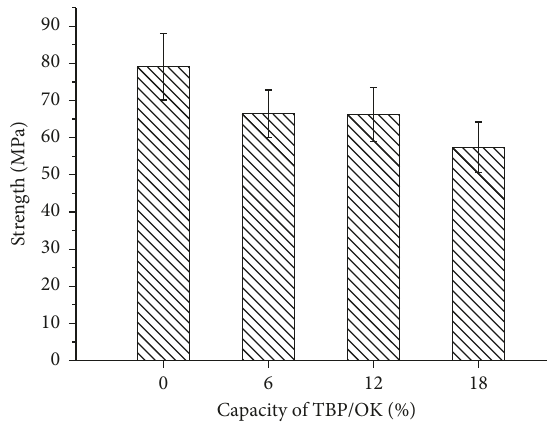
Figure 9: Compressive strength of the solidified SPTsamples with different TBP/OK